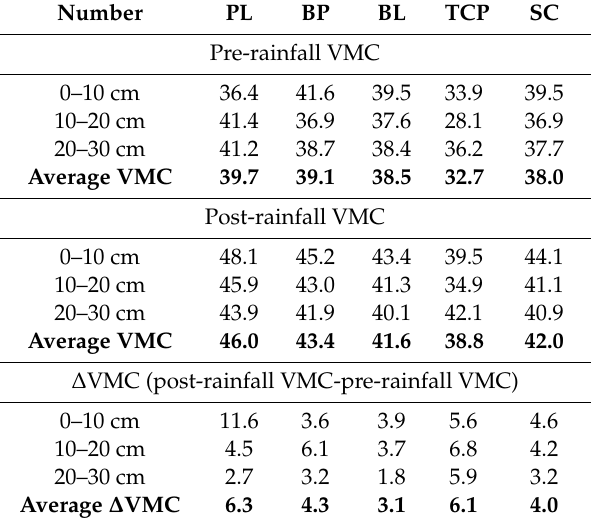
Table 3. Changes in the VWC of the soil at various depths before and after rainfall